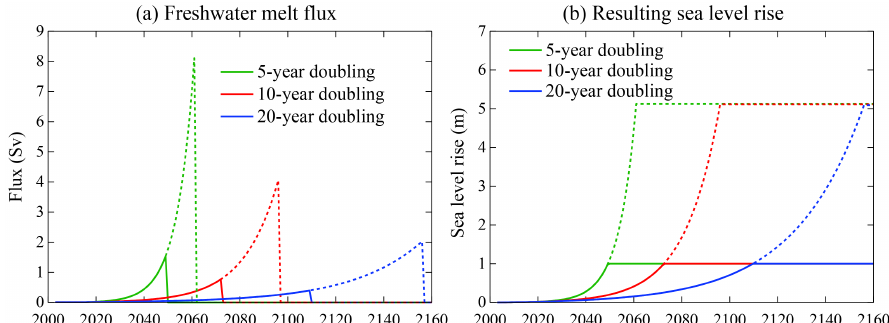
Figure 5. (a) Total freshwater flux added in the North Atlantic and Southern oceans and (b) resulting sea level rise. Solid lines for 1m sea level rise, dotted for 5m. One sverdrup (Sv) is 10 6 m 3 s − 1 , which is ∼ 3 × 10 4 Gtyear − 1 .